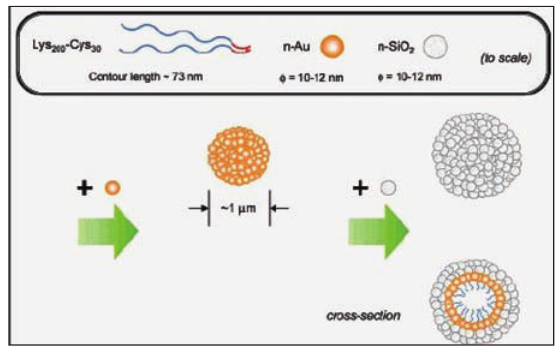
Fig. 6 Scheme of self-assembly of Au and SiO 2 nanopar- ticles 77)